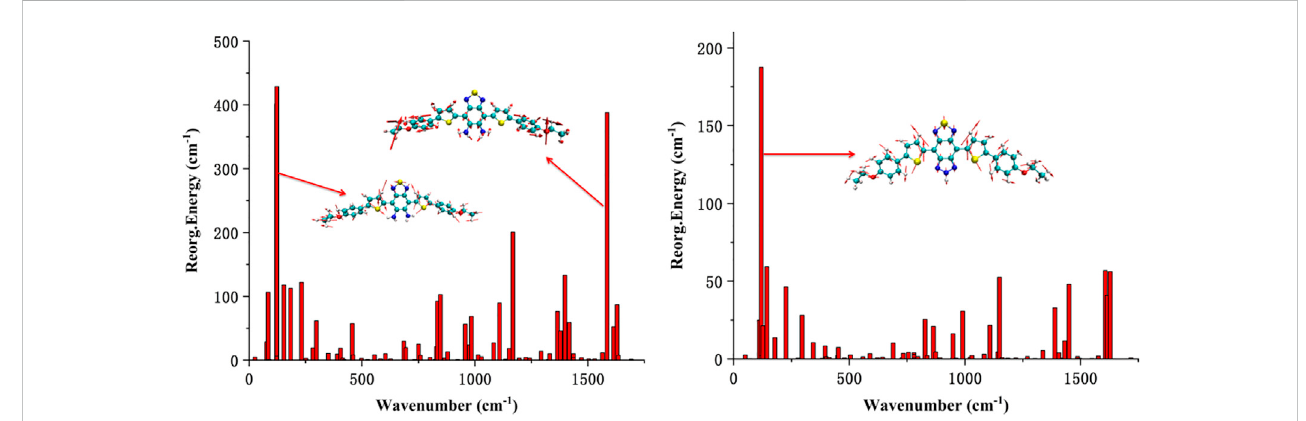
Calculated reorganization energy from each normal mode of DAD-NO and